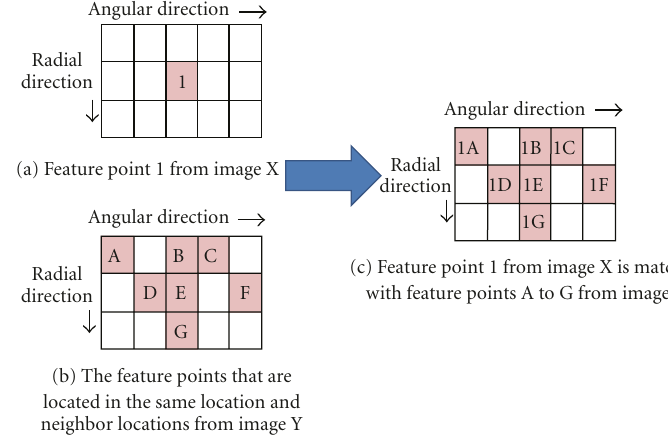
Figure 9: Feature point